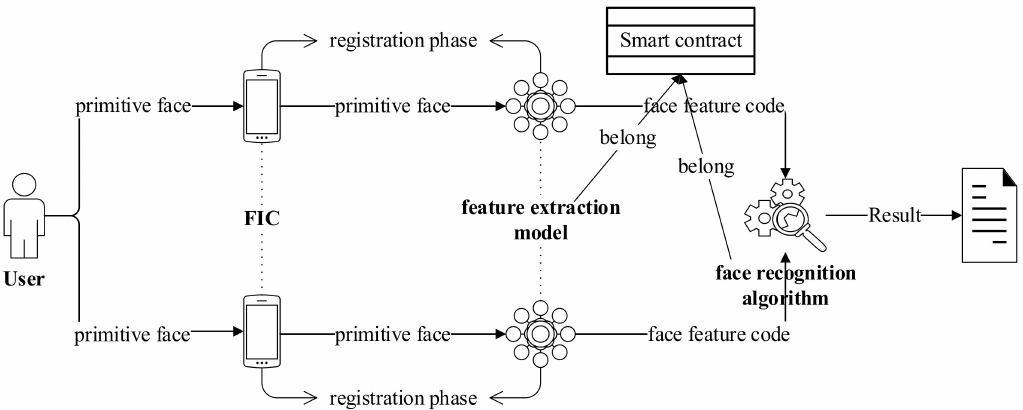
Figure 2. Face recognition model structure for cross-domain blockchain. The primitive face infor- mation is collected by FIC module, and then extracted by the face feature extraction module on the AS node. Then the face biometric features are stored in the consortium chain and used in the authentication stage.